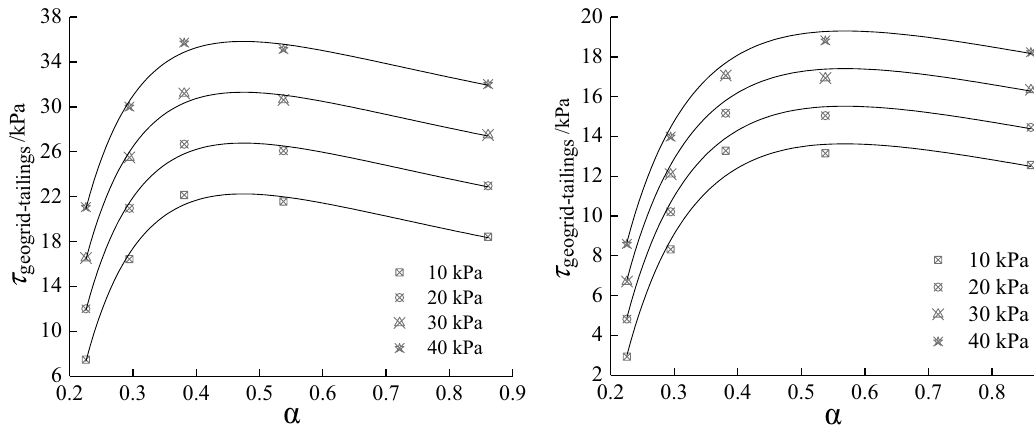
Figure 5. τ geogrid-tailings − α curve under different normal stress: ( a ) Direct shear test and ( b ) Pull out